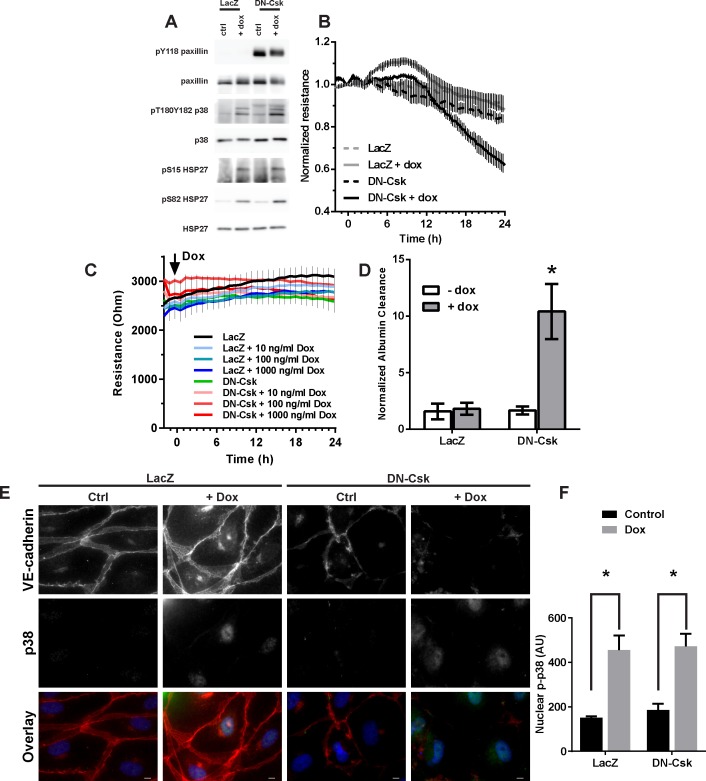
Concurrent activation of p38 and SFK pathways is sufficient to promote an increase in monolayer permeability.Pre-confluent monolayers of HDMEC were infected with lentivirus containing active FLAG-tagged MKK6 construct (iMKK6E) under the control of an inducible promoter. These cells were reseeded and allowed to become confluent for 3 days. Then, confluent iMKK6E-HDMEC monolayers were infected with adenovirus to express either LacZ or DN-Csk. After an additional incubation of 24 h, cells were treated with or without doxycycline to induce the expression of MKK6E in low serum media. A, Cells were then lysed 18 h later and assayed for SFK and p38 signaling by Western blot, demonstrating independent pathway activation. B, TEER was measured on ECIS electrodes in cells treated as in A. C, Cells expressing either LacZ or DN-Csk were treated with different concentrations of doxycycline and TEER was measured on ECIS electrodes for 24 h. D, FITC-Albumin permeability assay on Transwell chambers 18 h after doxycycline addition. Data presented as mean±SEM. Asterisk, p<0.05 (Two-way ANOVA and Tukey’s multiple comparison post-hoc test). Note the synergistic action to promote an increase in endothelial permeability. Results are representative of at least three independent experiments. E, Cells were fixed 18 h after doxycycline addition and stained for phosphorylated (pT180Y182) p38 and VE-cadherin. Nuclei were counterstained with DAPI. Note the nuclear localization of phospho-p38 in cells treated with doxycycline. Results are representative of at least three independent experiments performed in duplicate. F, Nuclear (pT180Y182) p38 fluorescence intensity was quantified from three fields from each treatment. Bar graphs and statistical analyses of TEER for the 20 h time point corresponding to B and C are shown in S6H and S6I Fig.